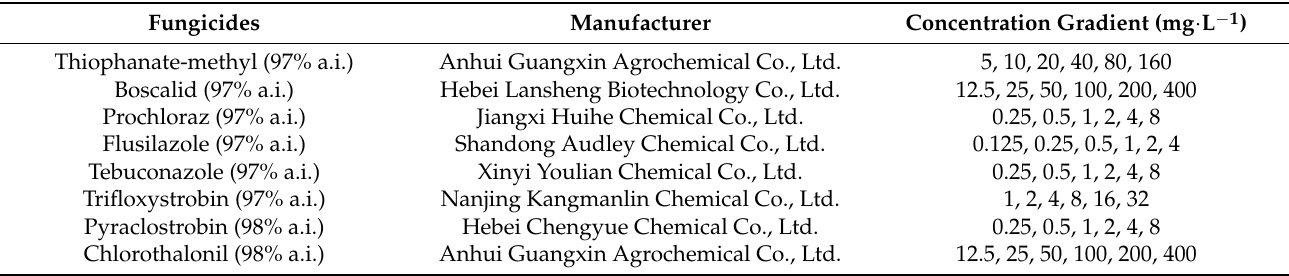
Table 3. Fungicides and experimental concentration